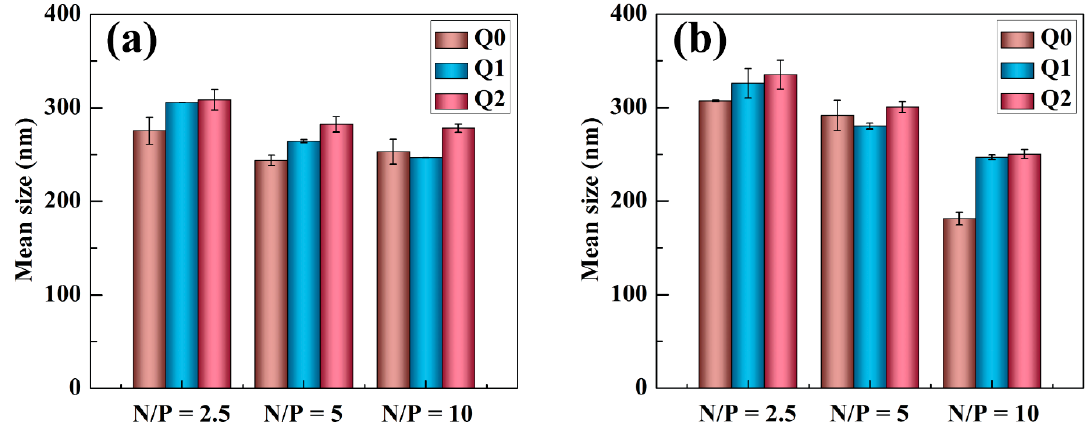
Figure 2. Mean hydrodynamic size of Bcl-2 siRNA ( a ) and VEGF siRNA ( b ) complexed with Q0, Q1, and Q2 at N/P ratios of 2.5:1, 5:1, or 10:1, respectively (mean ± SD, n = 3).